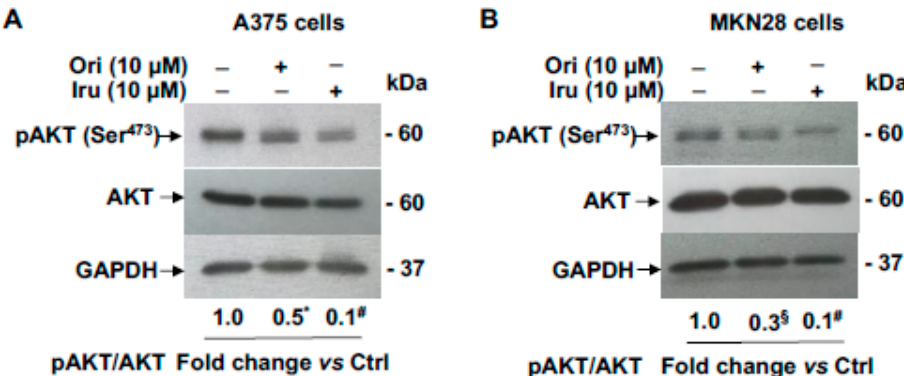
Figure 5. E ff ects of Ori and Iru exposure on AKT phosphorylation in A375 and MKN28 cells. Western blotting analysis of phospho-AKT expression levels in ( A ) A375 and ( B ) MKN28 cells treated with Ori and Iru for 24 h. The relative fold change vs. untreated cells, set as 1, of protein levels is shown under each lane. Values marked with *, § or # were statistically di ff erent from control (* p < 0.05; § p < 0.01, # p < 0.001). Statistical analysis of the results obtained in triplicate experiments are reported in the Figure S1.